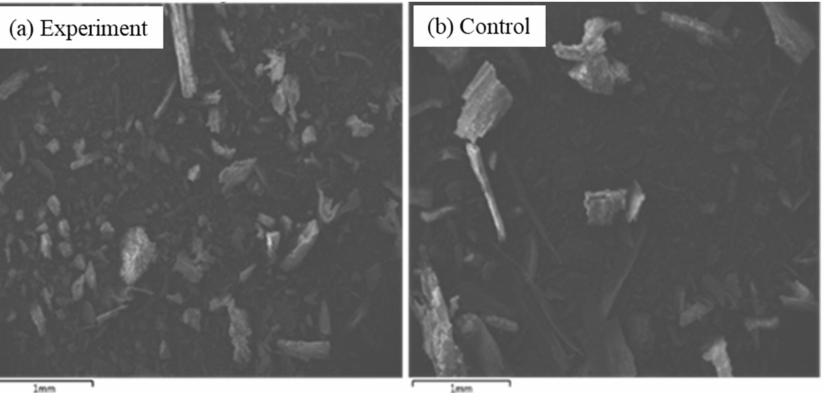
Figure 10. ( a , b ). SEM of Vetiveria zizanioides roots from AMD-treated wetland water ( a ) and con- trol wetland ( b